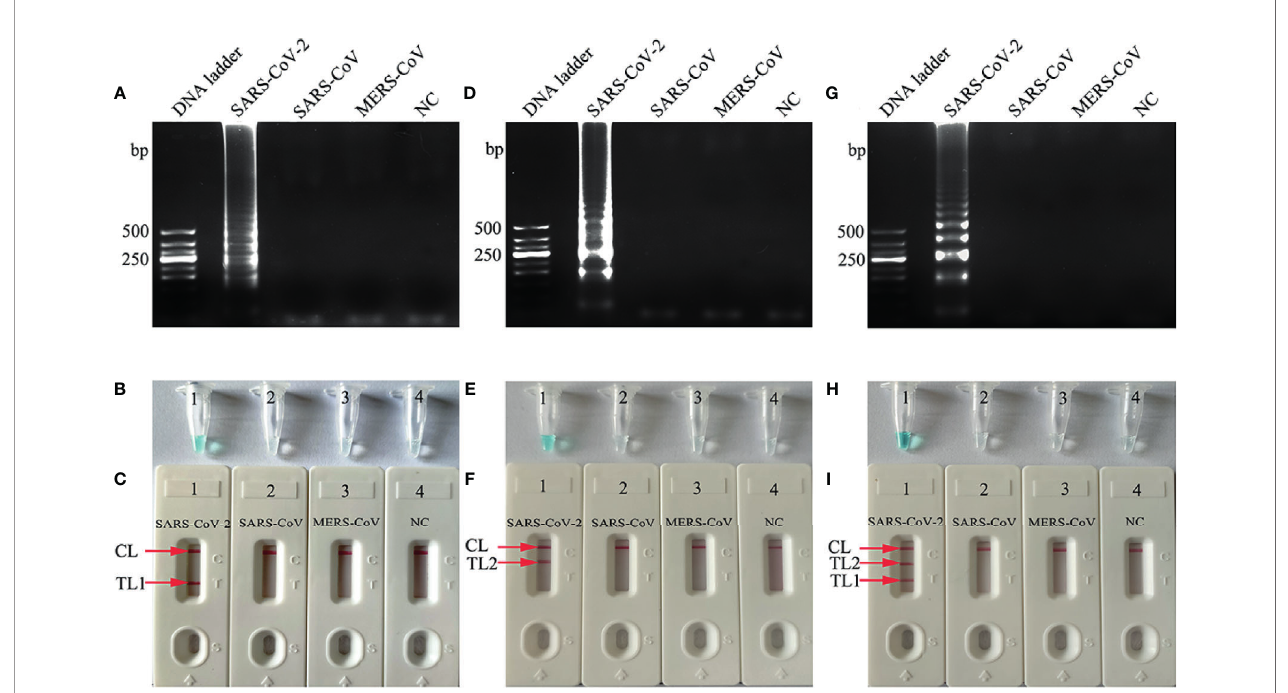
FIGURE 2 | Determination and veri fi cation of mRT-LAMP products. The RdRp -, N -, or mRT-LAMP mixtures, containing 1 × 10 4 copies of the RNA template, were incubated at a constant temperature of 65°C for 1 h, and the RT-LAMP products were identi fi ed with 2% agarose gel electrophoresis (A, D, G) , visual detection reagents (B, E, H) and lateral fl ow biosensor (C, F, I) . Viral RNA from pseudo-virus SARS-CoV, pseudo-virus MERS-CoV, and double distilled water (DW) were used as negative controls (NCs). Lane DNA ladder: 500 bp DNA ladder, the ladder-like bands indicate positive RT-LAMP ampli fi cation, the color changed from colorlessness to bright green indicates positive nucleic acid ampli fi cation. CL and TL1 appeared crimson red bands, indicating positive results of RdRp -RT-LAMP products, CL and TL2 presented crimson red bands, indicating positive results of N -RT-LAMP products, three crimson red bands (CL, TL1, and TL2) appeared indicating positive results of mRT-LAMP ampli fi